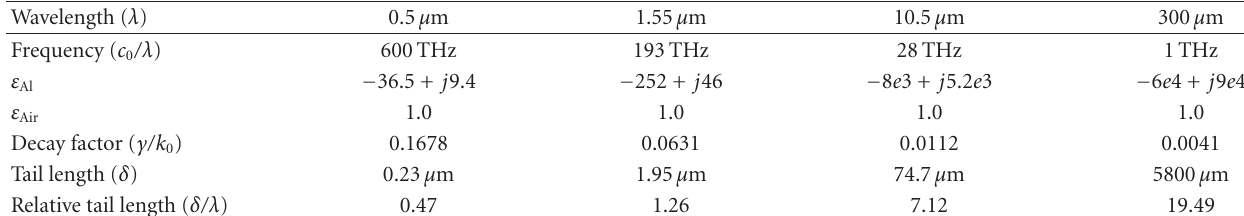
Table 2: The lengths of evanescent tails at di ff erent wavelengths for metal-insulator boundary.